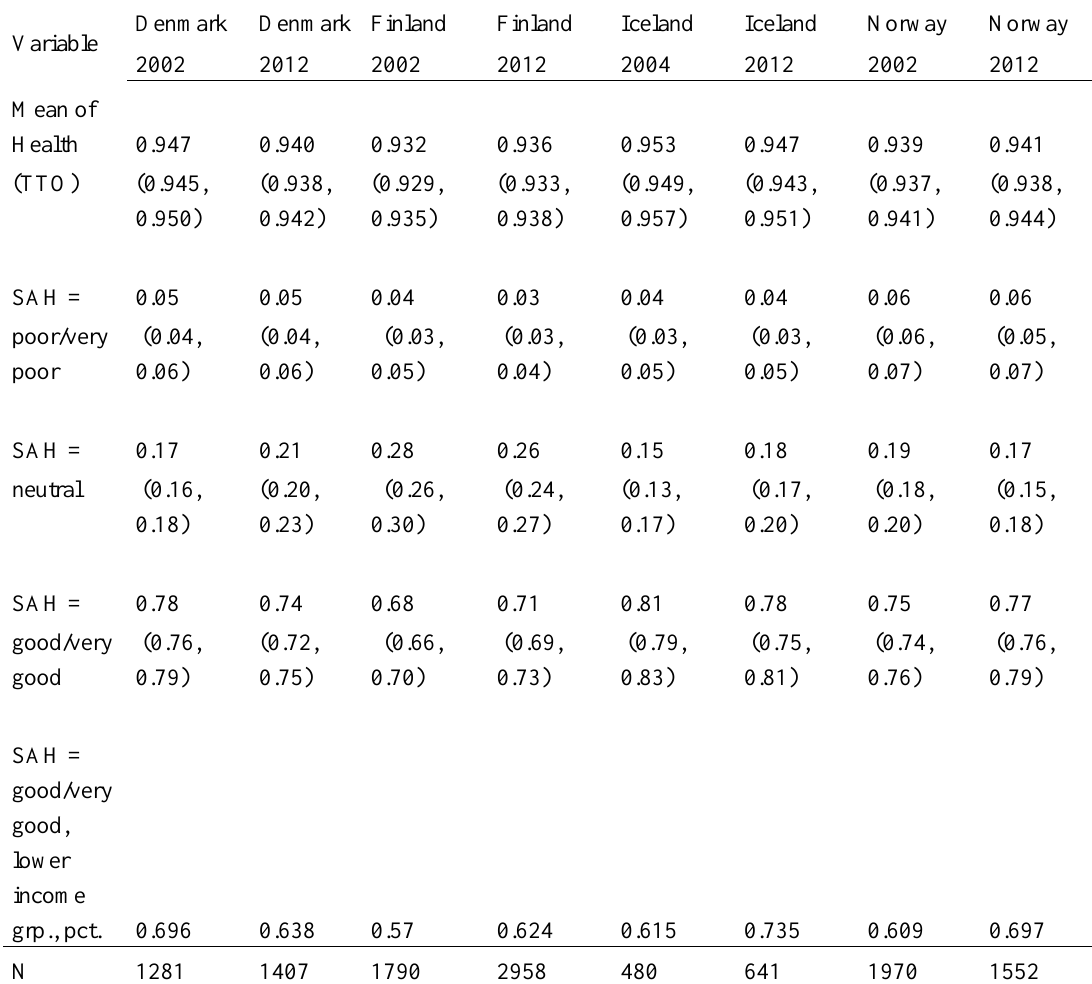
ESS results are weighted with EES post-sample weights. 95% confidence interval in brackets, Source: European Social Survey 2002 and 2012. (European Social Survey